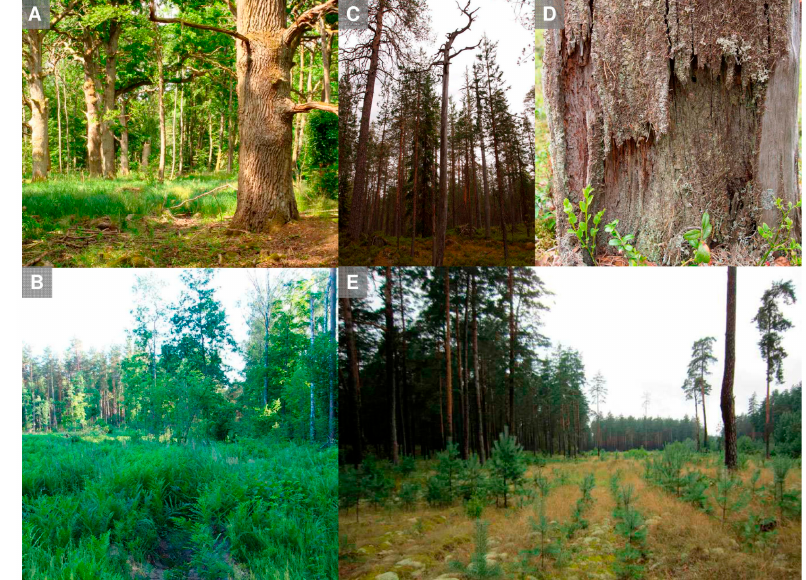
Figure 2. Variation of typical macro- and microhabitats across the European range in Cladonia parasitica , a specialized wood-inhabiting lichen. ( A ) Pedunculate oak ( Quercus robur ) stand in South Sweden, where it grows on dead branches, trunks, and stumps. ( B ) Clear-cut of a Scots pine ( Pinus sylvestris ) dominated stand in SE Belarus, where found on an oak stump. ( C , D ) Primeval boreal forest in Finnish Karelia, on old wood of decorticate Scots pine snag (‘kelo’). ( E ) Stumps and logs in managed pine forests in Lithuania. A and C illustrate well-known, regionally distinct habitats [107], while B and E represent historically poorly studied habitats (habitat bias). Photo courtesy: U. Arup ( A ), P. L õ hmus ( B , E ), A. L õ hmus ( C , D